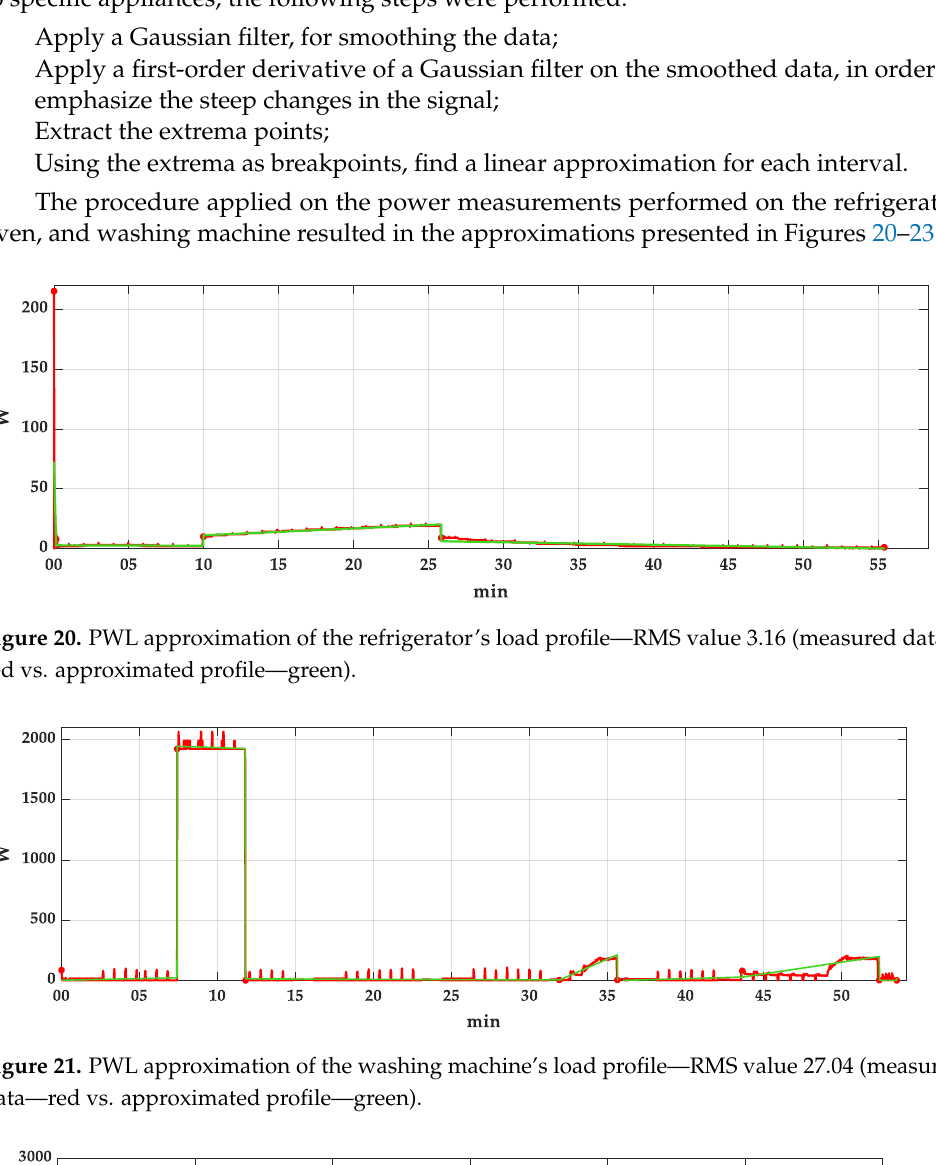
Figure 23. PWL approximations of the load profiles. The simple algebra involved in defining the summation operation is: 𝑃 = ∑ 𝑃 𝑖 (𝑡 − 𝑡 𝑖 ) 𝑛 𝑖=1 where P i ( t − t i ) is the PWL representation of the appliance i load profile (shifted with the time t i ). It allows the generation of artificial daily profiles based on real appliance load profiles. This fact demonstrates the versatility of the PWL representation in generating a sufficiently broad spectrum of daily profiles to simulate the optimization algorithms. The rescheduling of the loads is, in fact, in this representation, just equivalent with the time shifting of the appliance profiles. As an example, an artificial daily-load profile, generated by considering that the oven starts at 12:30 and at 18:30 and the washing machine starts at 16:00, is presented in Figure 24.